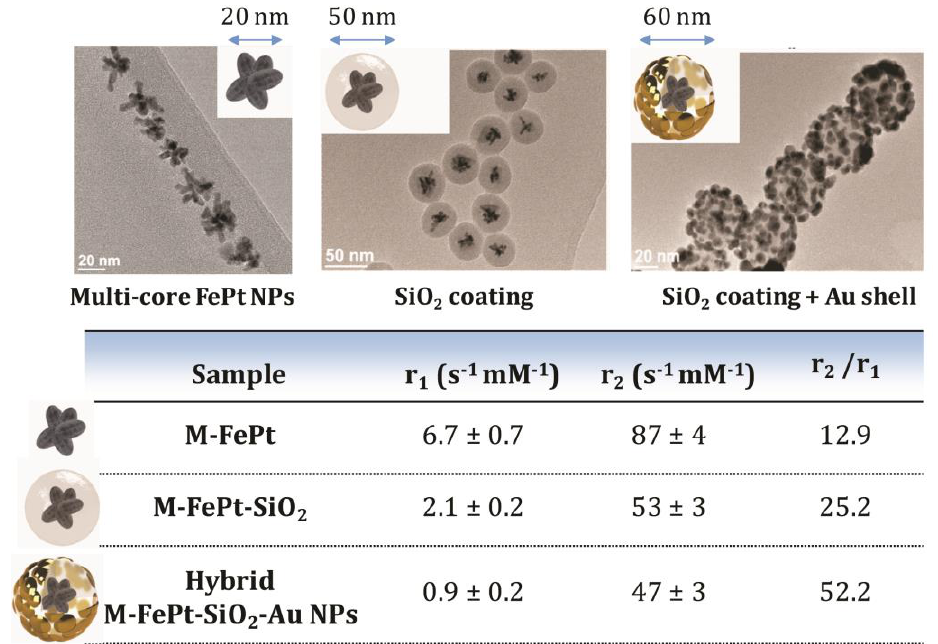
Figure 2. Influence of coating thickness on r 1 and r 2 relaxivity values. Adapted with permission from [23,25].